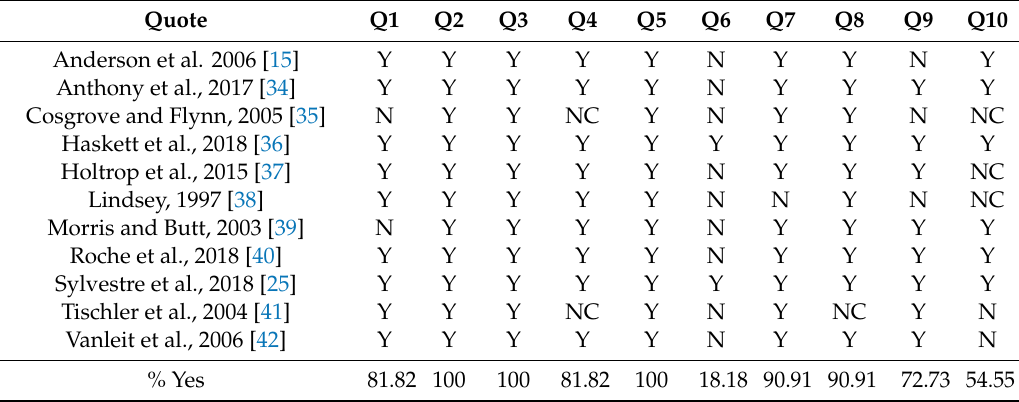
Table 2. Final evaluation of the included studies (according to the method used by Lockwood) [32]. Quote Q1 Q2 Q3 Q4 Q5 Q6 Q7 Q10